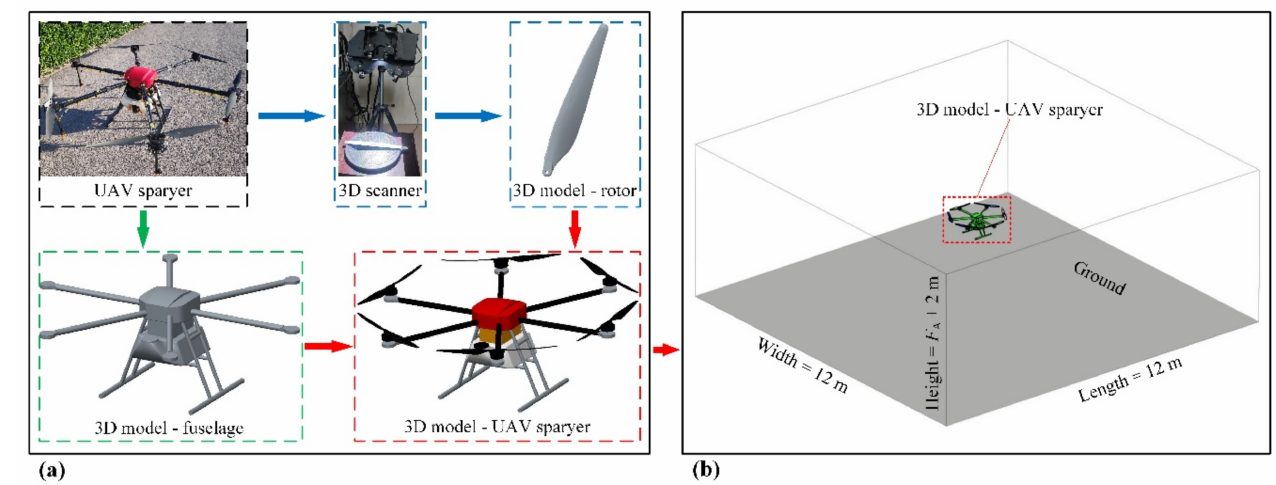
Figure 7. The numerical simulation of downwash airflow. ( a ) The process of creating a three-dimensional model of the UAV sprayer; ( b ) schematic diagram of the computational